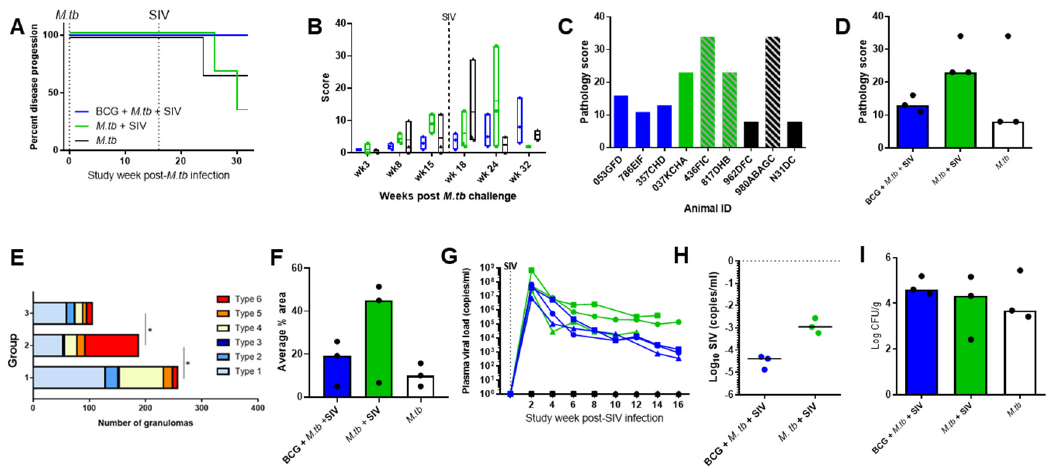
Figure 2. Measures of disease burden and progression in macaques following coinfection with M. tb + SIV or infection with M. tb alone. ( A ) Kaplan–Meier curve; ( B ) total score determined from CT scans; ( C ) combined gross pathology scores of all tissues measured, diagonal stripes indicate animals that were removed from the study early as disease progressed to meet humane endpoint criteria; ( D ) median combined gross pathology scores of the groups; ( E ) total number of granulomas (all types) in the lungs; ( F ) percentage of lung tissue covered with granulomas measured from microscopic analysis; ( G ) SIV viral load throughout the study; ( H ) median viral load measured in serum at postmortem for the SIV-infected groups; ( I ) median M. tb bacterial burden shown as the sum of CFUs/g cultured from all tissues analysed. Mann-Whitney U test performed on data set E, * denotes statistically significant difference p ≤ 0.05. Blue = Group 1: BCG + SIV + M. tb, green = Group 2: M. tb + SIV, black = Group 3: M. tb only. Median is shown for ( D , F , H , I ). Table 1. Gross pathology observed in histopathology lung tissue sections. Animal ID Discrete Lesions